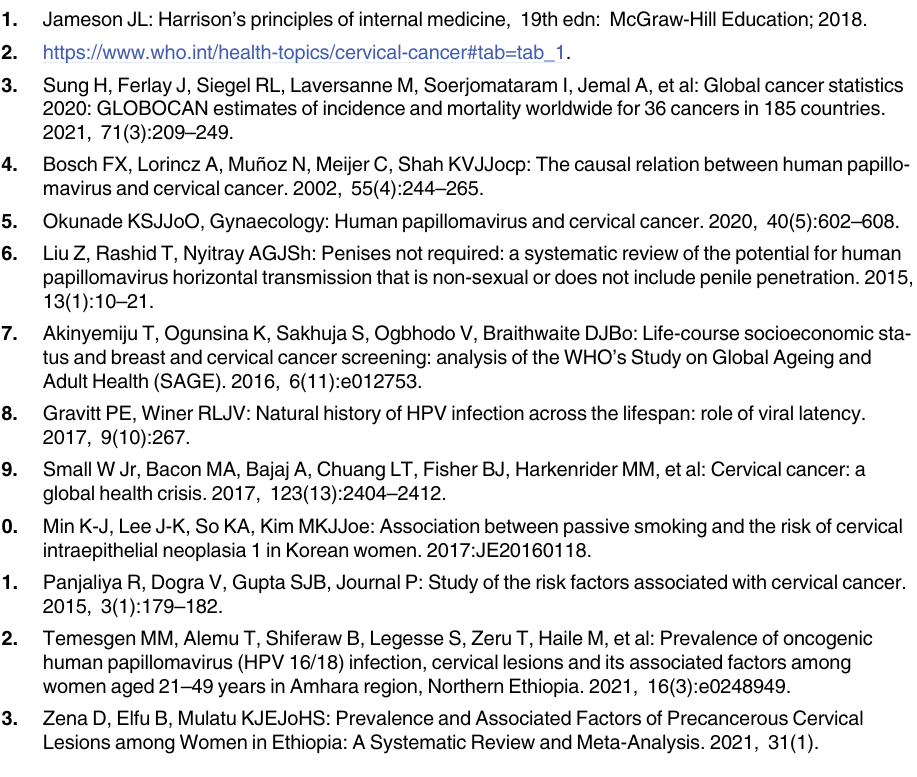
S1 Fig. Supporting file for dropping the outlier reports by two steps. An output from sensi- tivity analysis.